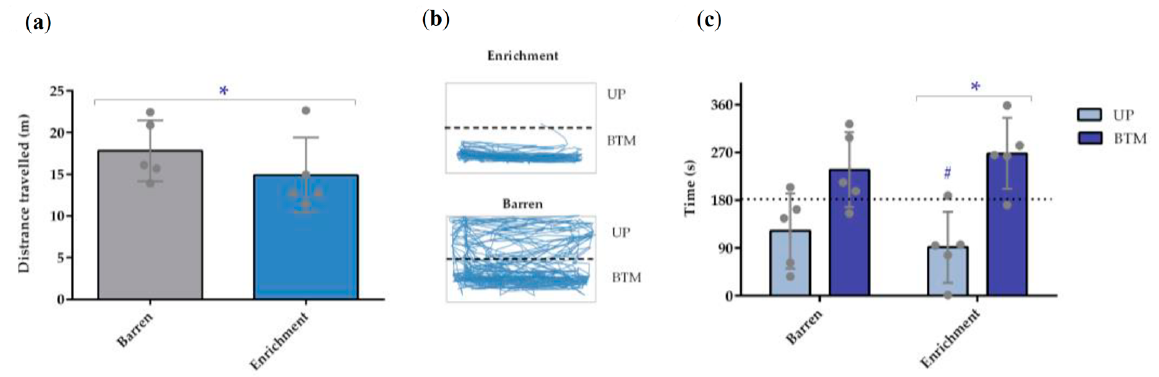
Figure 4. Locomotor activity of adult zebrafish during the novel tank test (n = 5). ( a ) Total distance travelled (m) by barren and enriched housed fish; ( b ) representative tracking example of one fish from each housing condition showing different behavioral patterns (AnyMaze software); ( c ) time spent (s) in each zone (UP and BTM) per housing condition. UP—upper zone of the tank; BTM—bottom zone of the tank. Data are expressed as mean ± standard deviation. * p < 0.05 for comparison between housing conditions in ( a ); * p < 0.05 for comparison between UP and BTM in enriched-housed animals in ( c ); # p < 0.05 for comparison between the time spent in the UP zone and the time spent there by chance (180 s). Each point represents one experimental unit, i.e., a tank .